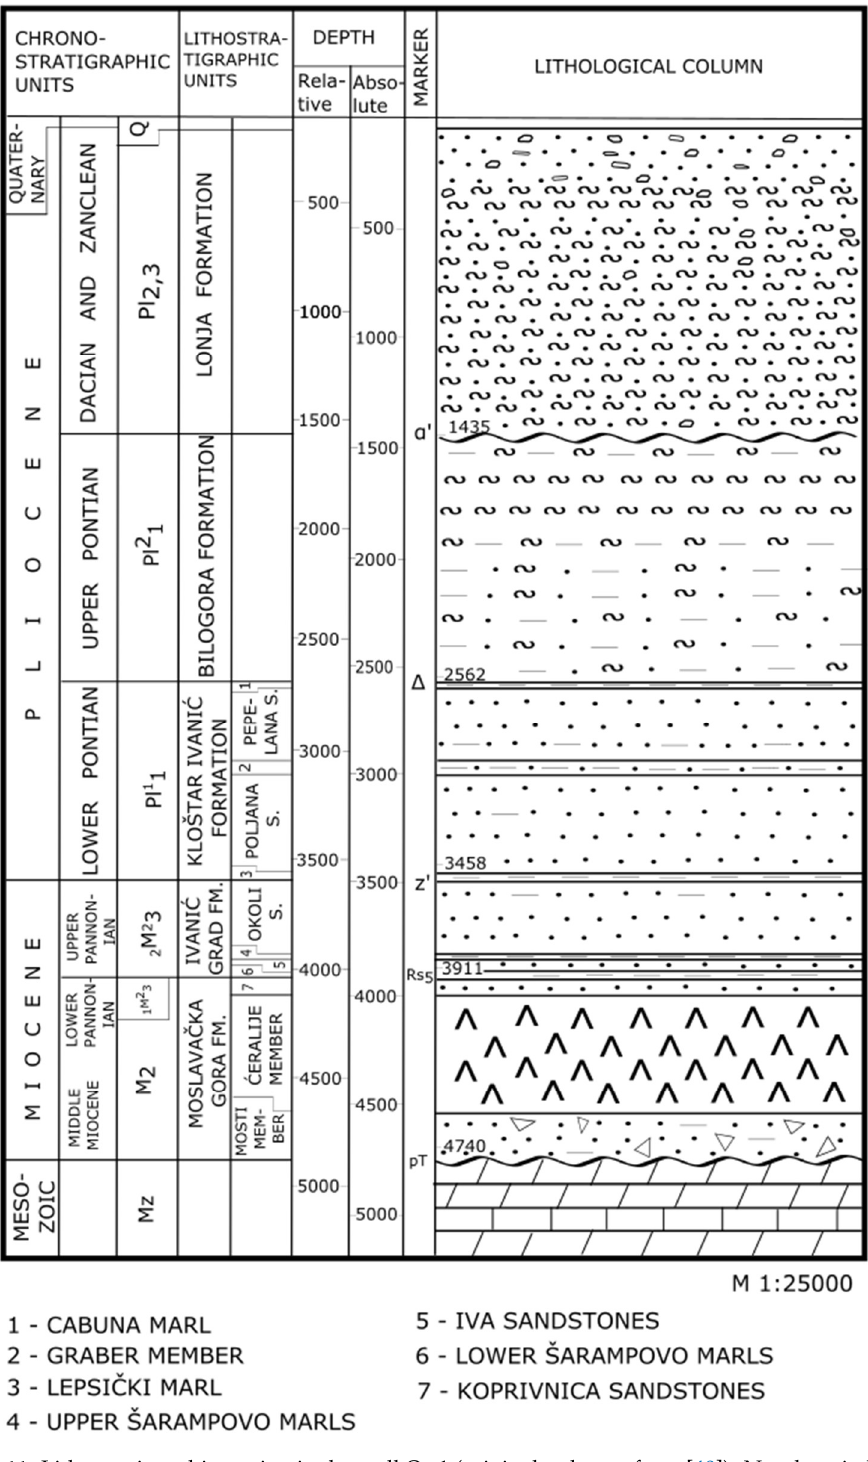
Figure 11. Lithostratigraphic section in the well Or-1 (original redrawn from [40]). Numbers in legend mark thin members.